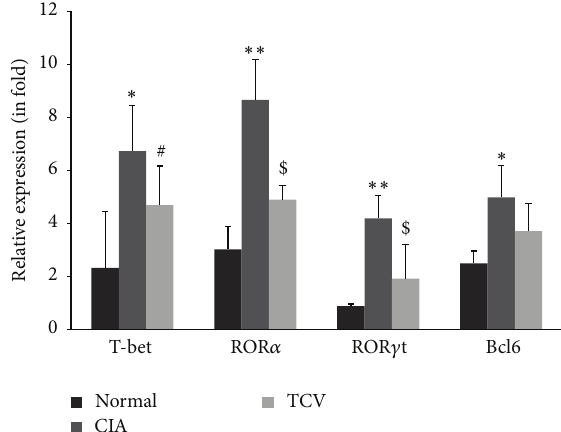
Figure4:TCVinfluencedtheexpressionsofTh1/Th17/TfhrelatedtranscriptionalfactorsinCIAmice.PurifiedCD4+Tcellsfromsplenocytes were prepared and analyzed for the mRNA expressions of T-bet, ROR 𝛼 , ROR 𝛾 t and Bcl6 by real-time RT-PCR. Data are presented as means ± SE. Data are represented as means ± SD ( 𝑛 = 10 mice/group). Data are representative of 5 separate experiments with similar results. ∗ 𝑃 < 0.05 , ∗∗ 𝑃 < 0.01 , CIA versus normal group. # 𝑃 < 0.05 , TCV versus normal group. $ 𝑃 < 0.05 , TCV versus CIA group.